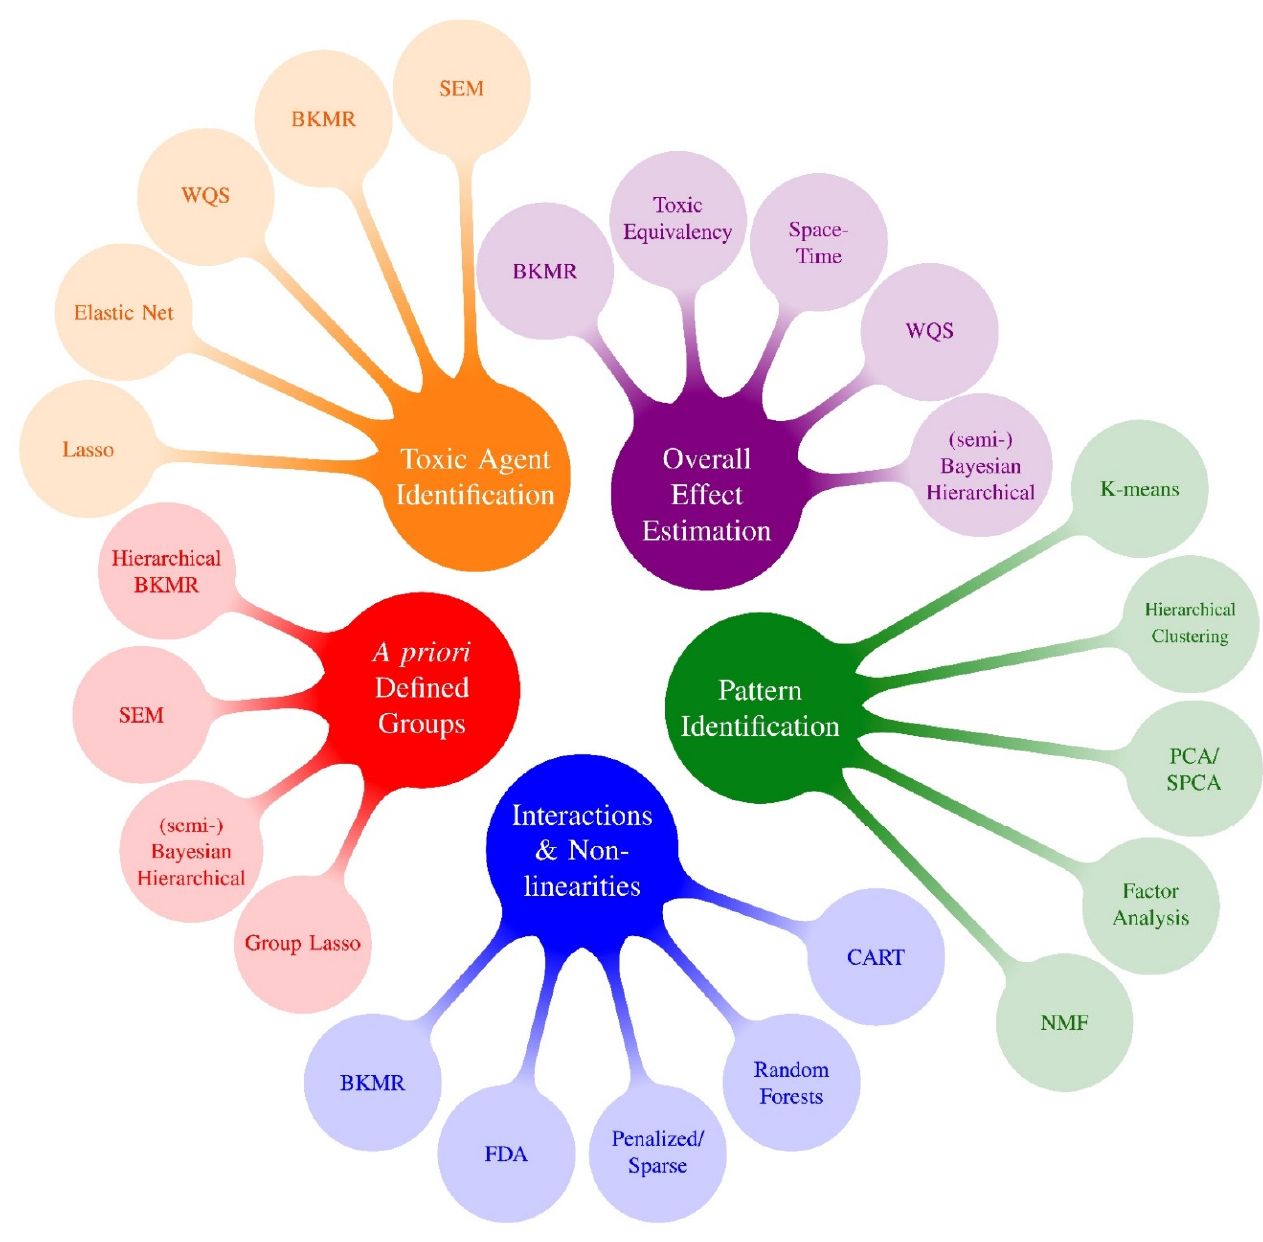
Figure 1. Mixtures Methods x Research Questions 1 : Methods Preceding PRIME. 1 Research questions